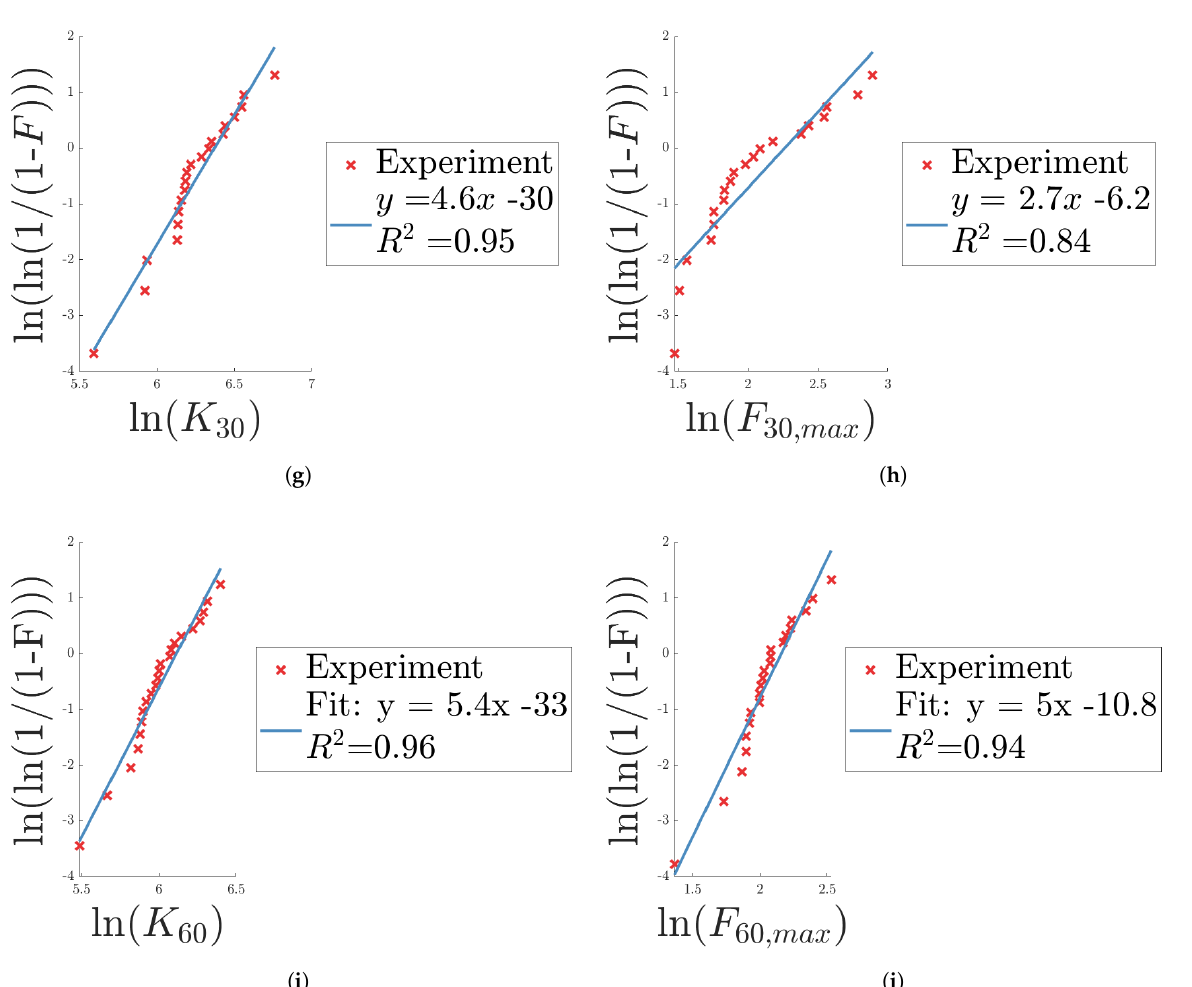
Figure 21. ( a–j ) contain the linearization (and goodness-of-fit) of the experimental data for each of the parameters in Table 4, from which the Weibull parameters are determined, according to the theory of Section